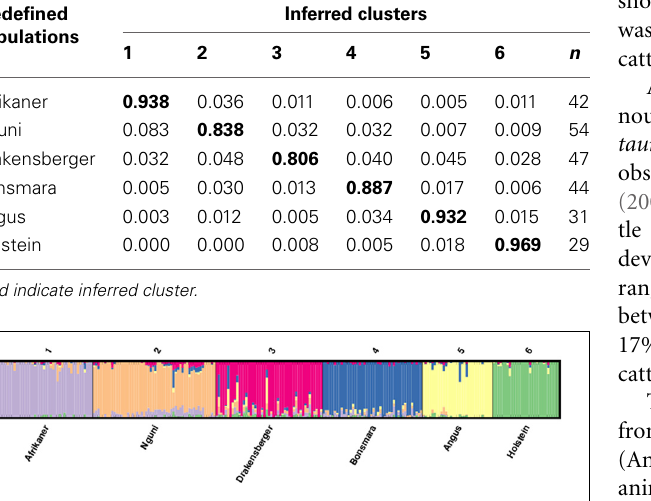
FIGURE 4 | ADMIXTURE clustering of six cattle breeds in South